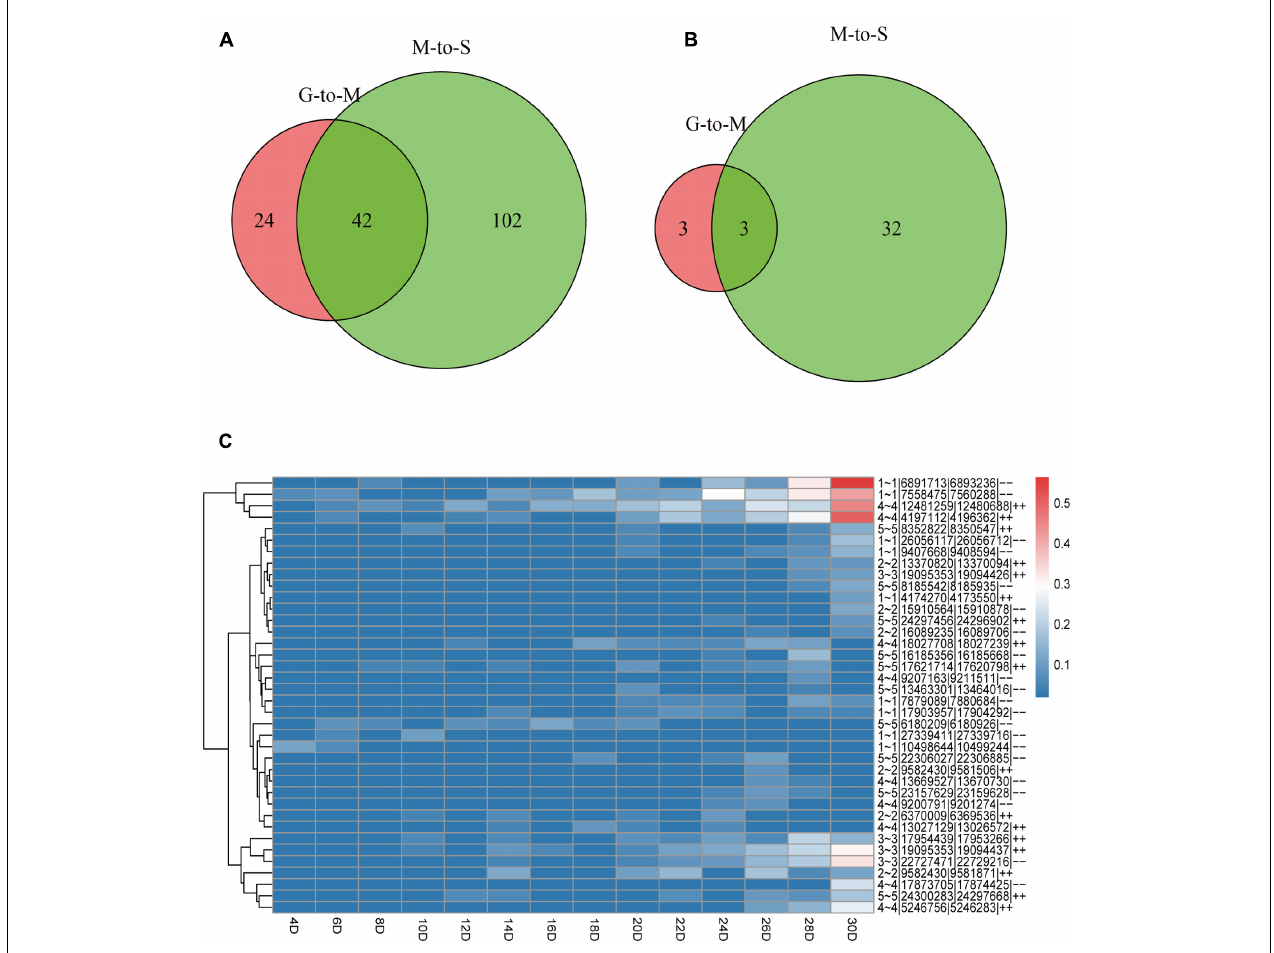
FIGURE 1 | The distribution of circRNAs during the lifespan of leaves and expression pattern of DE-circRNAs. (A) Numbers of circRNAs at G- to -M and M- to -S. (B) Numbers of DE-circRNAs at G- to -M and M- to -S. (C) Heat maps showing the expression patterns of 38 DE-circRNAs during leaf growth, maturation and